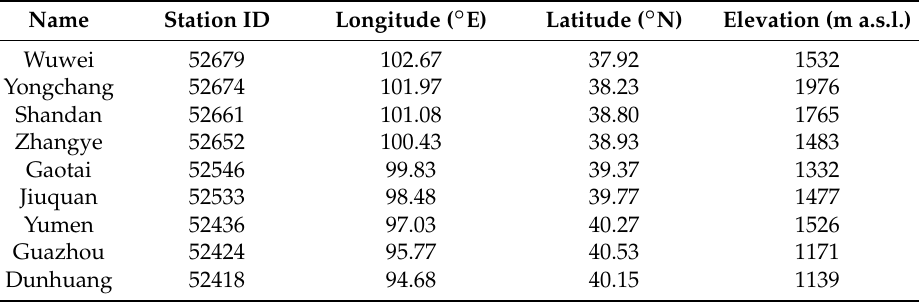
Table 1. Geographical descriptions of meteorological stations in the study area.